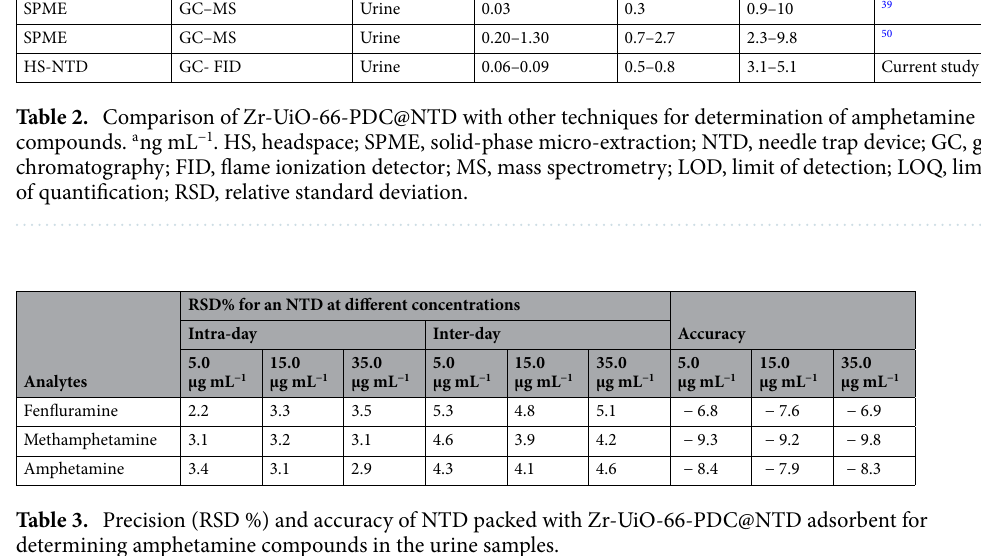
Table 3. Precision (RSD %) and accuracy of NTD packed with Zr-UiO-66-PDC@NTD adsorbent for determining amphetamine compounds in the urine samples.